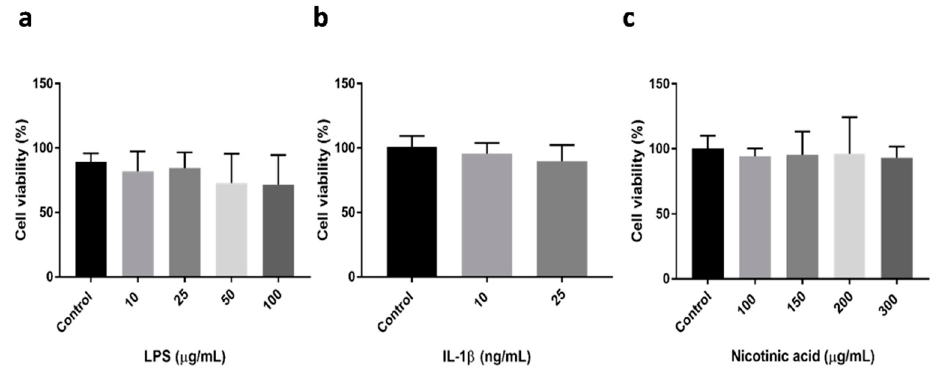
Figure 1. Effects of LPS ( a ), IL-1 β ( b ), and NA ( c ) on cell viability. Cell viability was evaluated after 48 h of incubation of each compound. Data, expressed as % of control, are presented as means ± standard deviation. Statistical analysis was performed using an unpaired Student’s t -test.